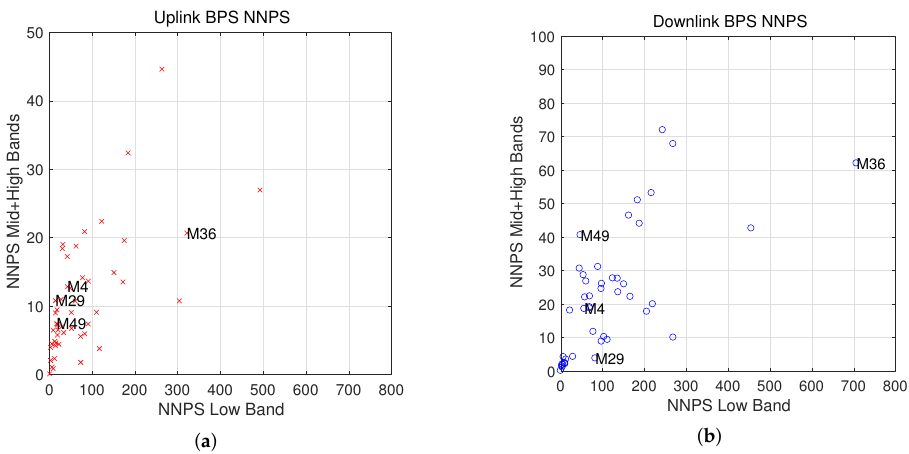
Figure 7. Scatter diagrams of the cumulative NNPS features (F7–F12) for Daejeon TS. ( a ) Uplink of F8 + F9 versus F7. ( b ) Downlink of F11 + F12 versus